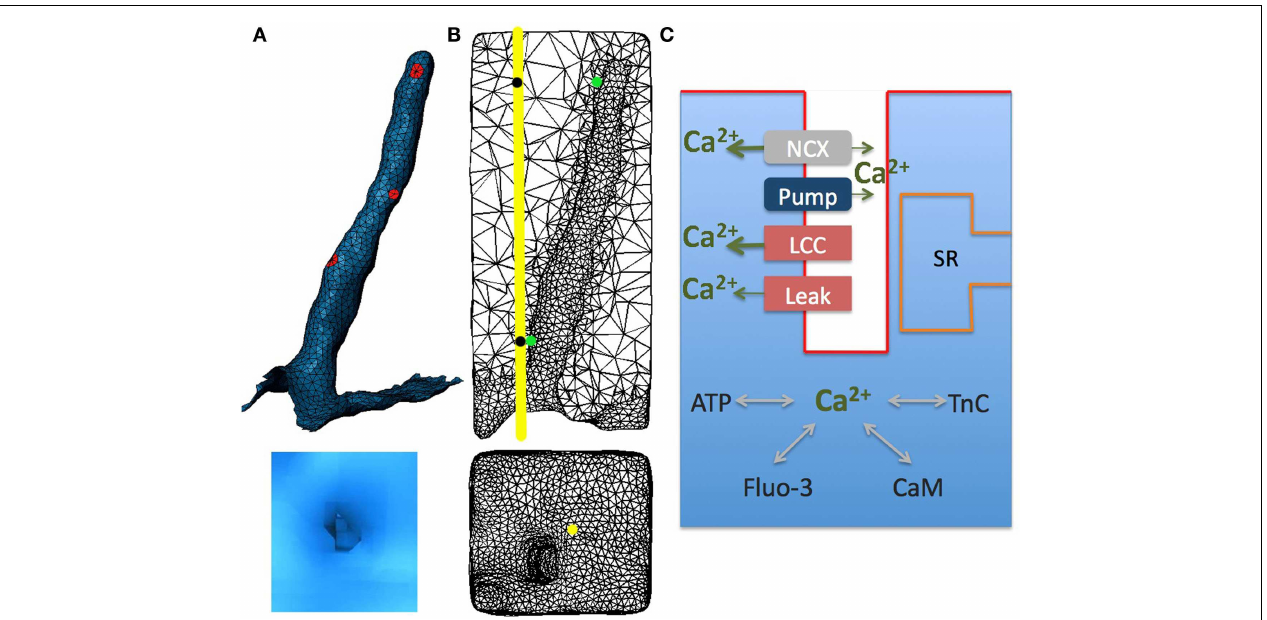
membrane Ca2 + ATPase pump; Leak, background sarcolemmal Ca 2 + leak; SR, sarcoplasmic reticulum;TnC, troponin C; CaM, calmodulin; ATP, adenosine triphosphate; Fluo-3, fluorescent dye. In all numerical experiments: LCC and NCX current densities were ninefold and threefold higher, respectively, in the t-tubule membrane; Ca 2 + leak and pump were uniformly distributed along the sarcolemma; LCC clusters (diameter of ( ∼ 200nm) had the same current density in the outer and t-tubular sarcolemma.The line-scan was positioned at 200nm away from the t-tubule mouth [yellow line and yellow spot in (B) ]. Local Ca 2 + transients were extracted at two featured spots along the scanning line (black spots) and along the t-tubule membrane (green